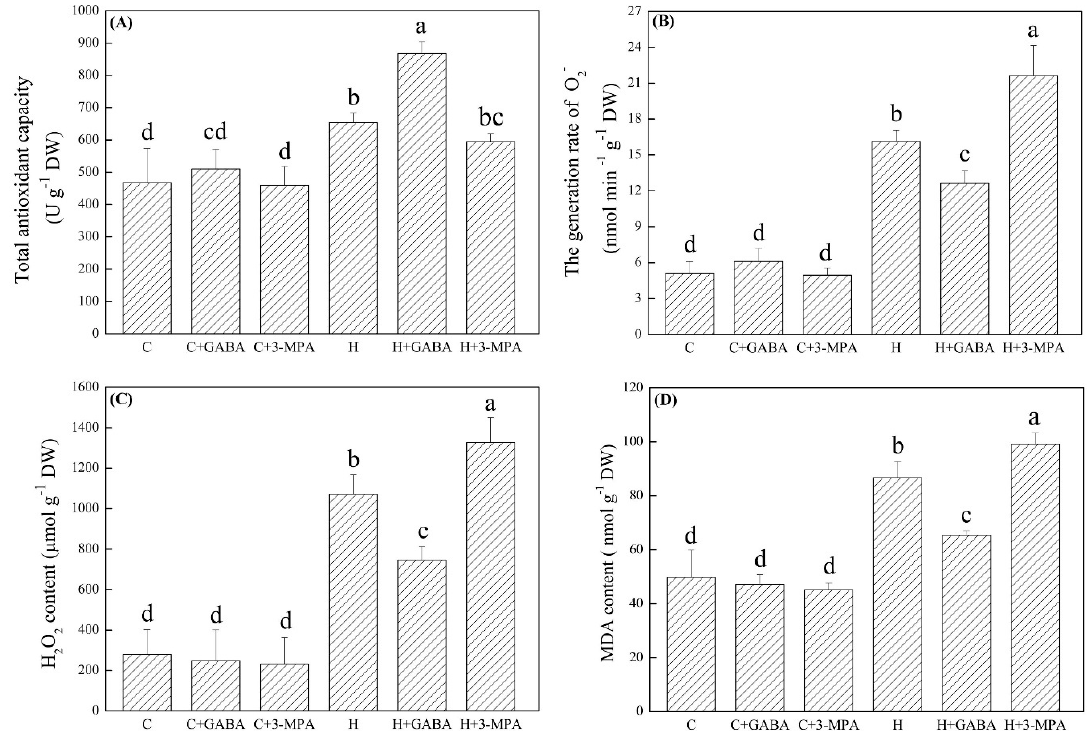
Figure 5. Effects of γ -aminobutyric acid (GABA) and 3-mercaptopropionic acid (3-MPA) on ( A ) total antioxidant capacity (TAC), ( B ) superoxide anion (O 2 . − ), ( C ) hydrogen peroxide (H 2 O 2 ), and ( D ) malondialdehyde (MDA) content in leaf of creeping bentgrass at 30 d of 23/18 (normal condition) or 38/33 °C (heat stress). Vertical bars above columns indicate ±standard error (SE) of means ( n = 4) and different letters above columns indicate significant differences ( p ≤ 0.05). C: control; C+GABA: control + GABA; C+3-MPA: control+3-MPA; H: heat; H+GABA: heat + GABA; H+3-MPA: heat+3-MPA.